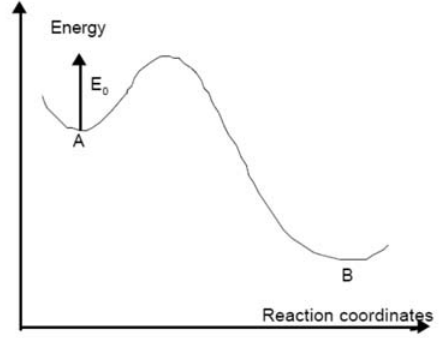
Figure 15. Chemical pathway between A and B.